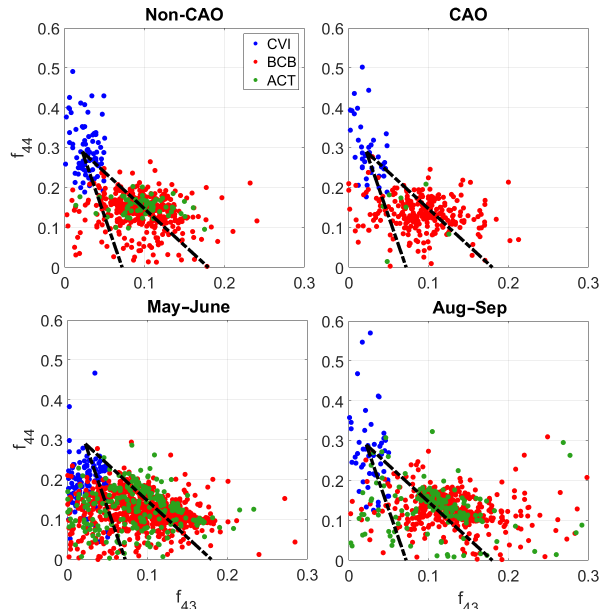
Figure 6. Comparison of f 44 and f 43 for individual BCB and ACT legs out of cloud, in addition to CVI data in cloud legs. Panels rep- resent different seasons with winter deployments (January–March) separated into CAO and non-CAO days. Superimposed on the plots are triangles corresponding to how former work (Ng et al., 2010) compared these ratios. Points with organic mass concentration less than 0.5µgm − 3 were omitted from this analysis.